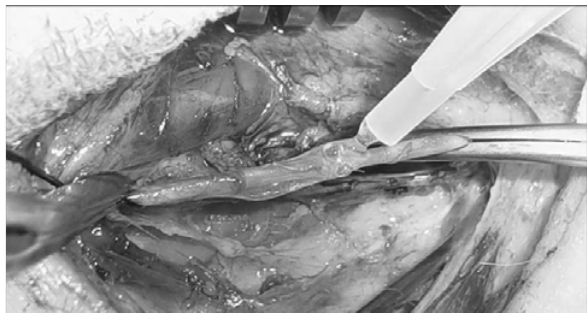
Fig. 2 - Anastomose recebendo o selante de fibrina